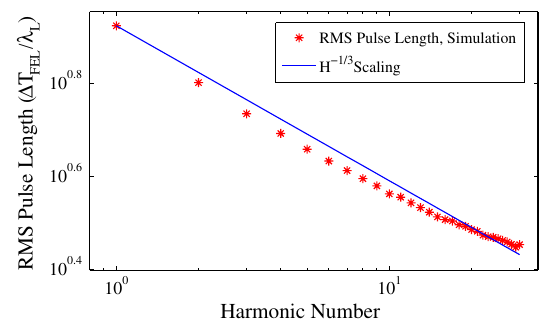
FIG. 6. Pulse length as a function of harmonic number. Simulation pulse lengths determined from the electron bunching factor (stars) follow the expected H (cid:1) 1 = 3 scaling